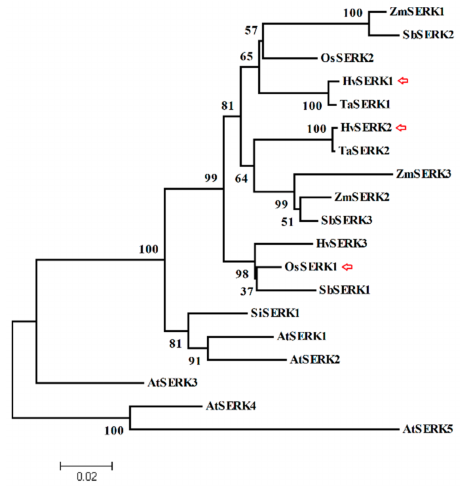
Figure 2. Phylogenetic analysis of the three barley SERK proteins and other plant SERK amino acid sequences. OsSERK1 (BAD05545.1), OsSERK2 (XP_015636497.1) from Oryza sativa ; TaSERK1 (AEP14551.1) and TaSERK2 (AEP14552.1) from Triticum aestivum ; ZmSERK1 (NP_001105132.1), ZmSERK2 (CAC37639.1), and ZmSERK3 (CAC37642.1) from Zea mays ; SbSERK1 (EES13434.1), SbSERK2 (XP_002447957.1), and SbSERK3 (XP_002454054.1) from Sorghum bicolor ; SlSERK1 (NP_001233866.1) from Solanum lycopersicum ; AtSERK1 (NP_177328.1), AtSERK2 (AAK68073.1), AtSERK3 (AAK68074.1), At-SERK4 (NP_178999.2), and AtSERK5 (NP_179000.3)from Arabidopsis thaliana . The red arrows show SERK proteins from Hordeum vulgare